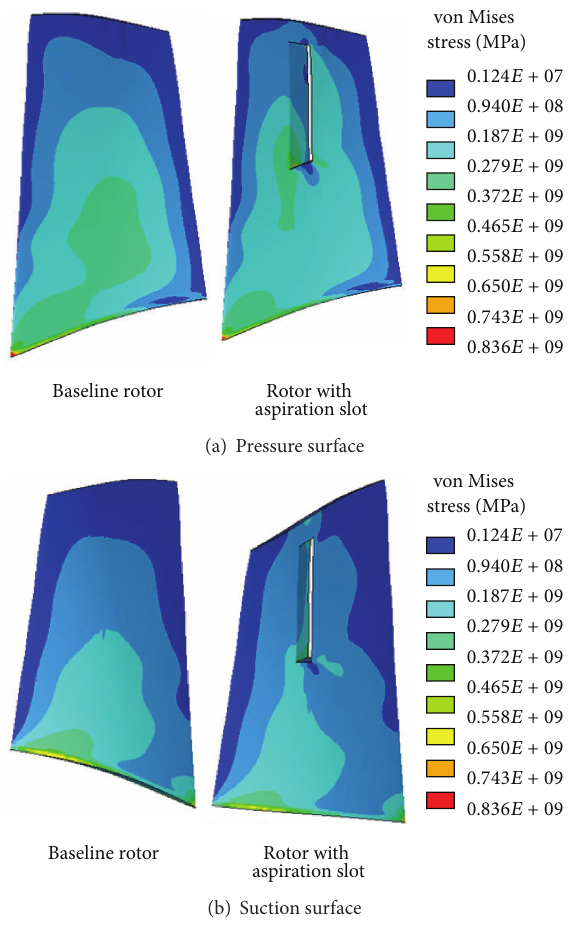
Figure 18: von Mises stress distribution on pressure and suction surfaces of the rotor blade without and with aspiration (AR37-2) at design mass flow rate.